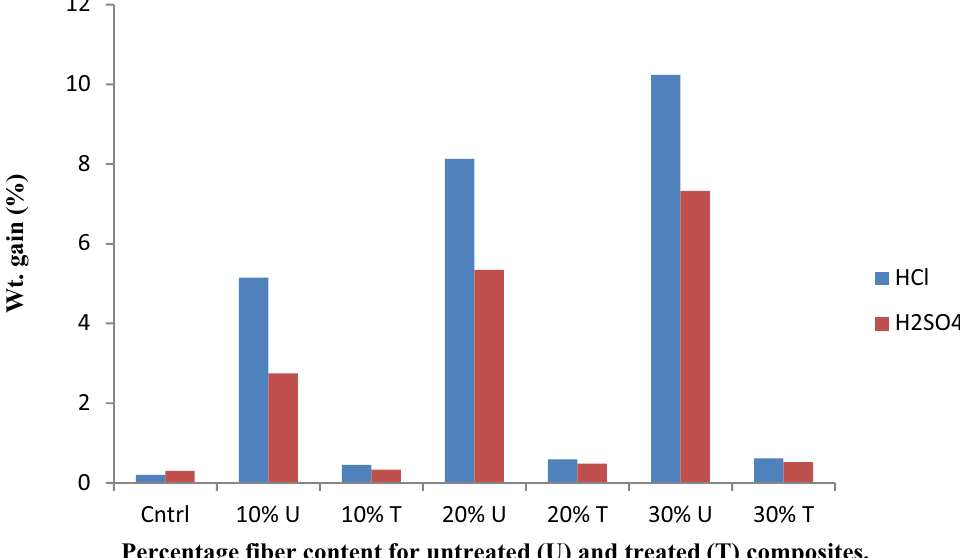
Figure 2. Acid chemical resistance test of the